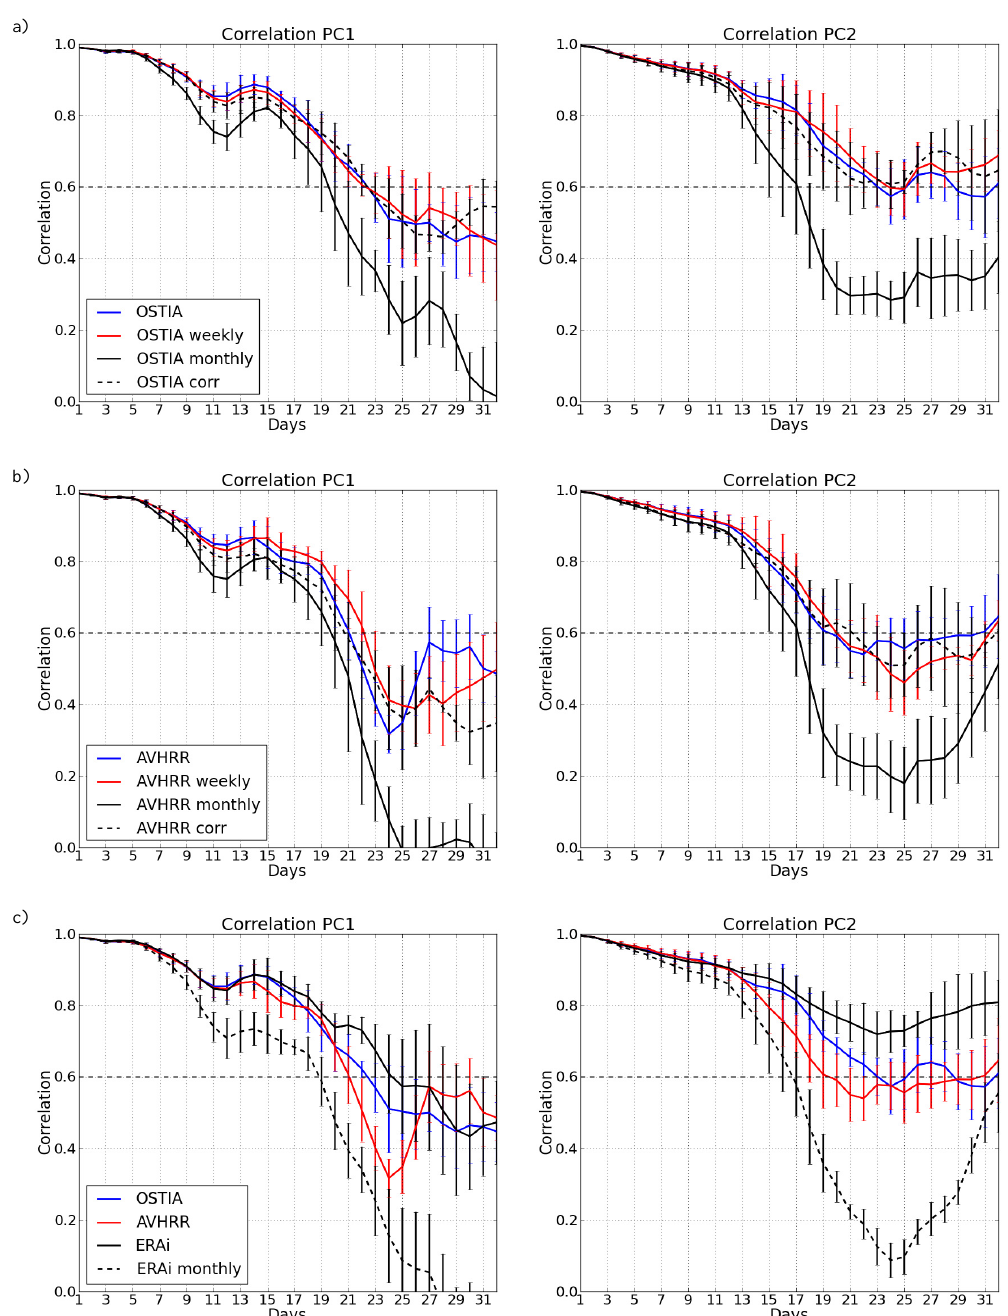
Fig. 5. Correlation of the PC1 (left) and PC2 (right) from the reanalysis with the ensemble mean forecast time series, based on 47 start dates (15 December 1992 to 31 January 1993), for the atmosphere-only experiments performed with the ECMWF forecast system at the T L 159 resolution. (a) Forcing by OSTIA SST at original (daily) temporal resolution (black line), weekly (blue line) and monthly (red line) temporal resolutions. The black dashed line is the forcing, where OSTIA SST mean state is corrected with respect to ERAi SST. (b) Same as (a) for AVHRR SST. (c) Forcing by original OSTIA (blue line) and AVHRR (red lines) products and by ERAi SST at their original (weekly) and monthly resolutions (solid and dashed black lines, respectively). The signifcance level (correlation of 0.6) is highlighted by a horizontal black dashed line. Error bars stand for the ensemble